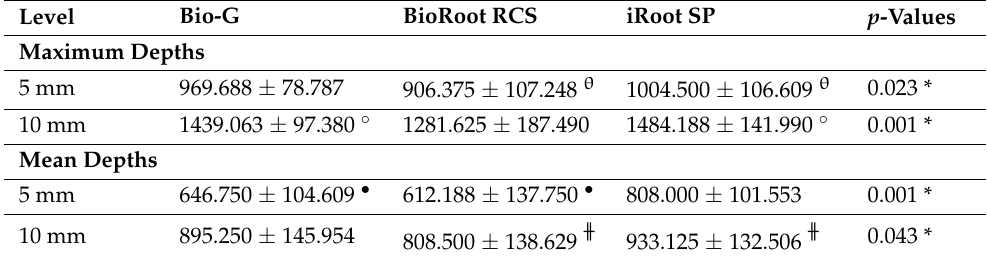
Table 3. Maximum and mean penetration depths ( µ m) of different